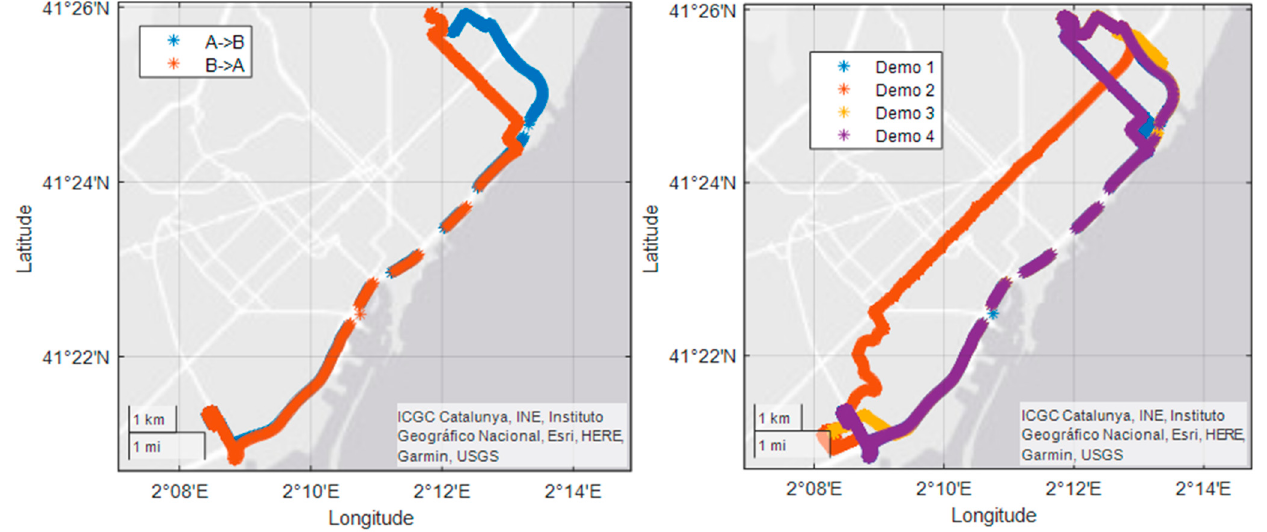
Figure A1. Route map of H16 for the demonstration .